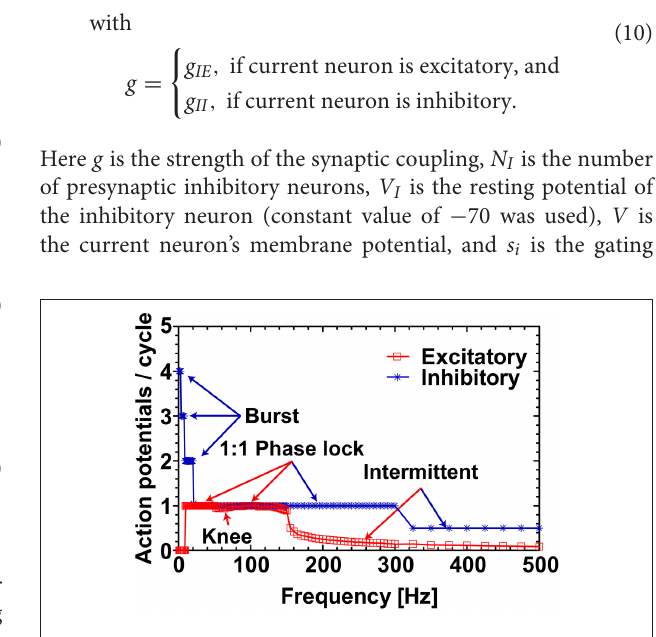
FIGURE 2 | Excitatory and inhibitory neurons response profile at 38 mV. The response profile of excitatory and inhibitory neurons as a function of number of spikes generated per cycle of sinusoidal stimulation at 38 mV. The applied frequency was from 1 to 500 Hz with a step of 1 Hz for 1–50 Hz, 2 Hz for 51–150 Hz, 5 Hz for 151–300 Hz, and 25 Hz for 301–500 Hz. The firing behavior outlined (“Burst,” “ 1 : 1 Phase lock,” and “Intermittent”) are in complete agreement with the reference map shown in Figure 1 . The “Knee” corresponds to the switching behavior (i.e., from 1 : 1 phase-lock to intermittent and back to 1 : 1 phase-lock) of the excitatory neuron in the frequency range ∼ 50 − ∼ 90 Hz as noticed in Figure 1